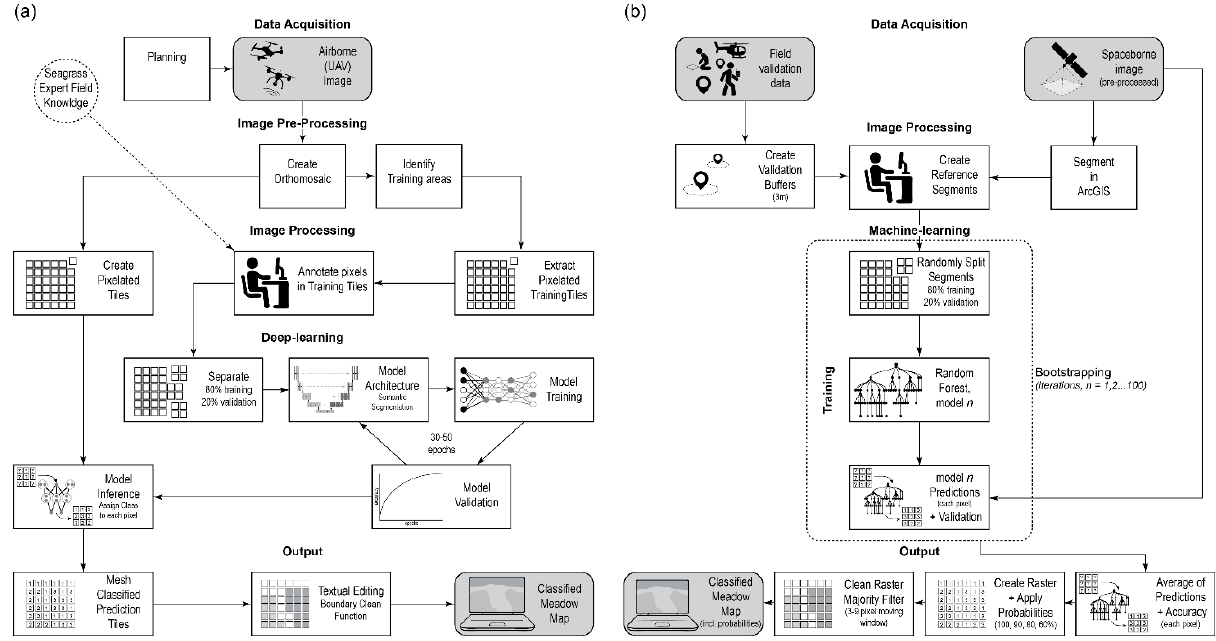
Figure 3. The general workflow of optical imagery acquired by UAV ( a ) and spaceborne sensors ( b ), illustrating the image processing and application of deep ‐ and machine ‐ learning ( a and b , respec ‐ tively) to produce spatially explicit classified seagrass meadow